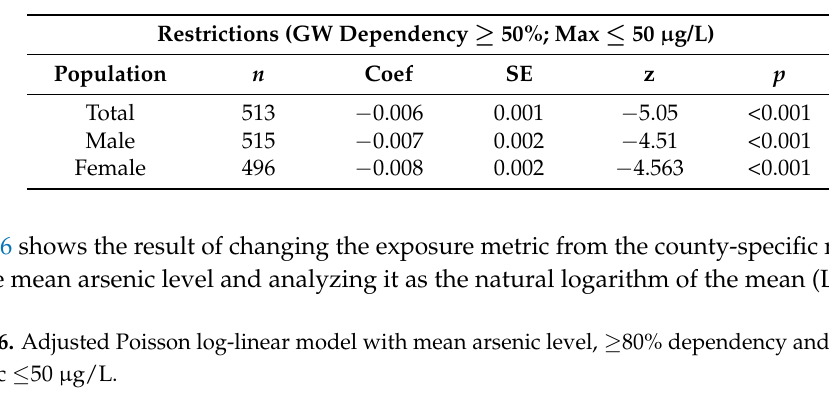
Table 5. Adjusted Poisson log-linear model with ≥ 50% dependency and maximum arsenic ≤ 50 µ g/L.